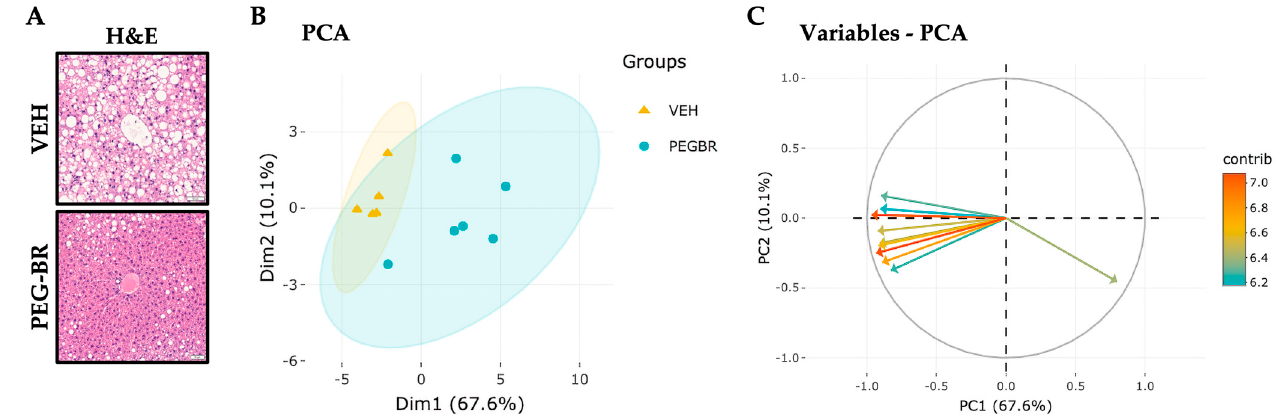
Figure 1. Hepatic lipids and lipid species clusters in the livers of obese mice treated with biliru- bin nanoparticles or vehicle . ( A ) Hematoxylin and eosin (H&E) staining of bilirubin nanoparticles (PEG-BR) and vehicle (VEH) treated mouse livers (scale bar = 50 μ m). ( B ) PCA plot showing the clustering of the VEH and PEG-BR liver lipid species, and ( C ) showing the top lipid species (arrows) and their contribution to the clustering.